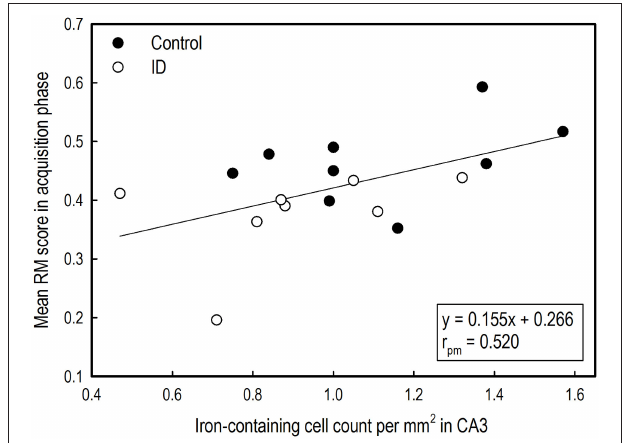
FIGURE 8 | Correlation between average reference memory scores in the acquisition phase of the holeboard task and iron-containing cell count in hippocampal sections after iron staining of ID ( n = 8 ) and control ( n = 9 ) animals at 12 weeks of